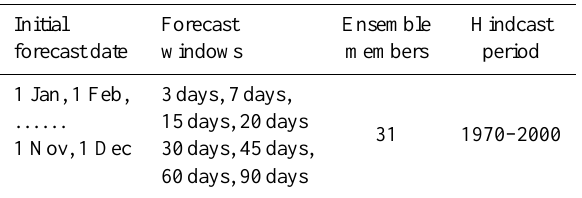
Table 3. Details of the experiment designs (for deriving the rela- tionships of β and the forecast skills).